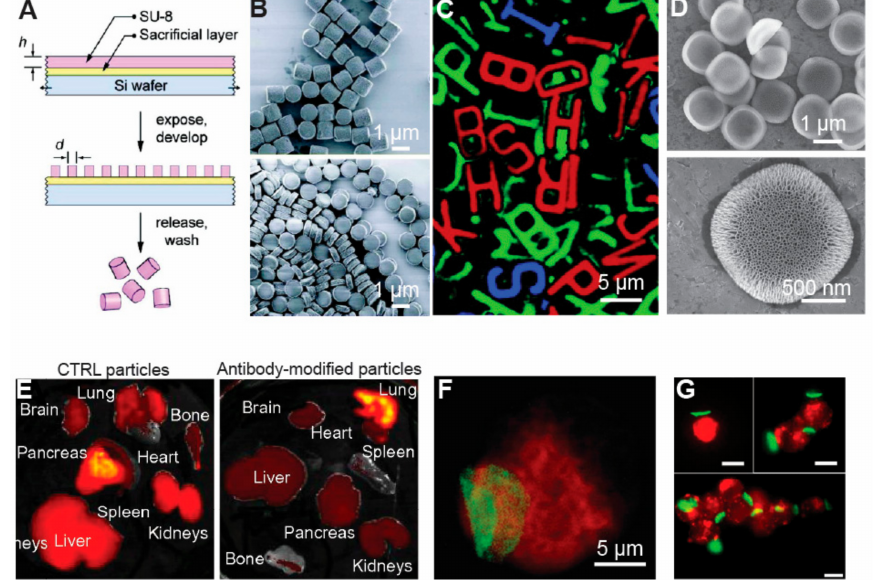
Figure 2. Photolithography-based techniques were employed to generate micro/nanoparticles with controllable features for delivering therapeutic cargos. ( A ) In photolithography-based particle production techniques, a layer of photoresist was coated onto a sacrificial layer (i.e., SU-8). UV light passed through a photomask with certain features onto the photoresist layer, with micro/nanostructures of the thin film defined by photomask features. Through dissolving the sacrificial layer, free micro/nanoparticles were produced [101], with permission from © American Chemical Society; ( B ) Photolithography-based techniques allowed the production of micro/nanoparticles with variable aspect ratios. Particles with two different aspect ratios were produced in this study [101], with permission from © American Chemical Society; ( C ) The versatility of photolithography-based particle production techniques was exemplified by producing particles of 26 Latin alphabet letters [103], with permission from © American Chemical Society; ( D ) Photolithography techniques were used to produce silicon microparticles with porous structures [105], with copyright permission from © Springer Nature; ( E ) The porous silicon in Figure 2D was used to treat mice in vivo. The unmodified particles accumulated in different organs such as the liver and pancreas, etc., whereas the antibody-modified particles mainly accumulated in the lung [107], with permission from © Elsevier; ( F ) Photolithography-produced microparticles with a disk shape were attached onto a monocyte cell surface. Such a platform will allow us to develop a cell-based delivery system by loading therapeutic cargo onto particles [111], with copyright permission from © Elsevier; ( G ) The photolithography technique was used to produce particles with a thin disk shape for assembling different number of cells. The cellular aggregates with a controlled number of cells could be employed for cell therapy. Scale bars were 20 µ m if not specified [111], with permission from © American Chemical